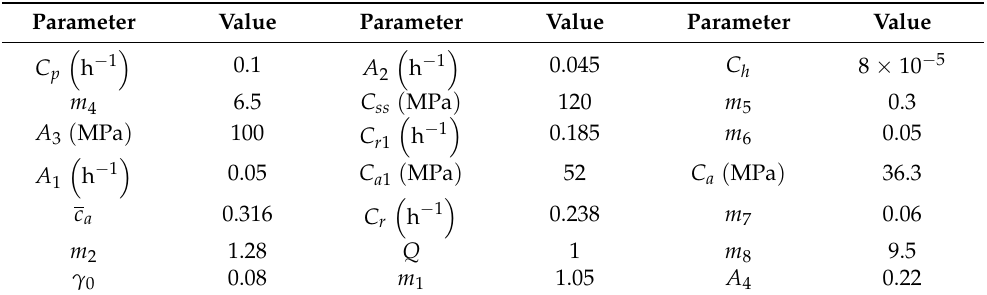
Table 2. Summary of material constants used in the model for the artificial aging of AA2050-T34. Data from [9].